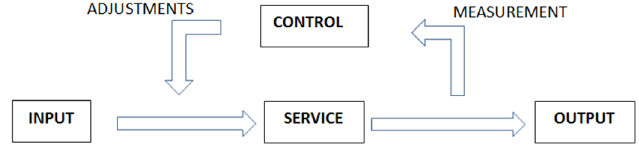
Fig. 1. Flowchart of an ISO 9001 general process.